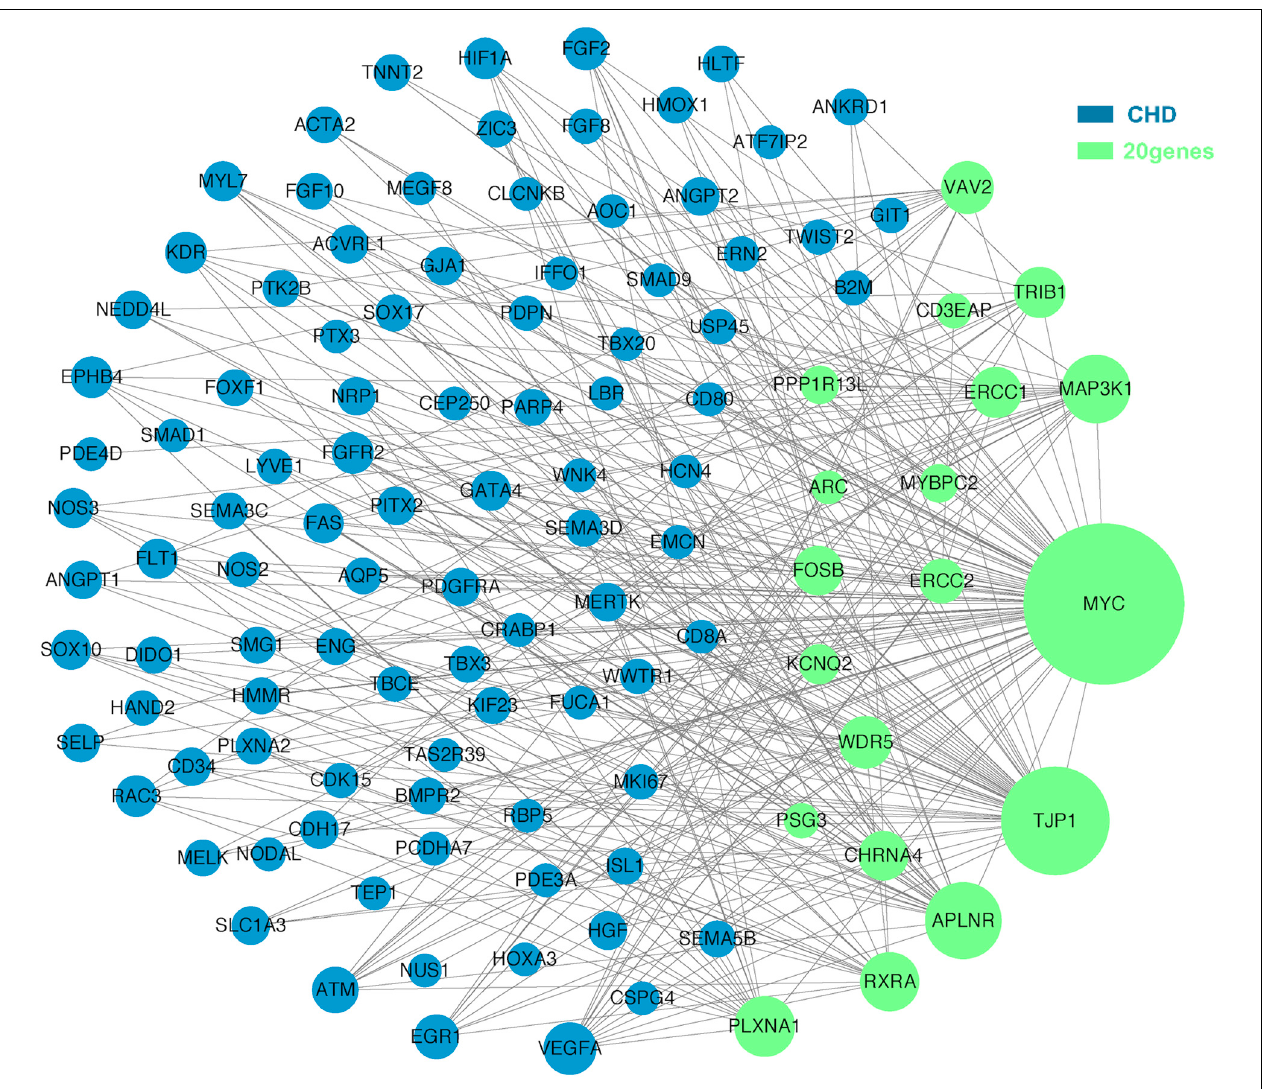
FIGURE 4 | A protein-protein interaction (PPI) network was constructed between candidate genes and known pathogenetic genes of CHD. The green nodes represent rare CNVs loci genes in this study and the blue nodes represent the genes in list 1. The different size of the green nodes represent different intensity of the protein interaction, and the larger the green nodes, the closer the interaction